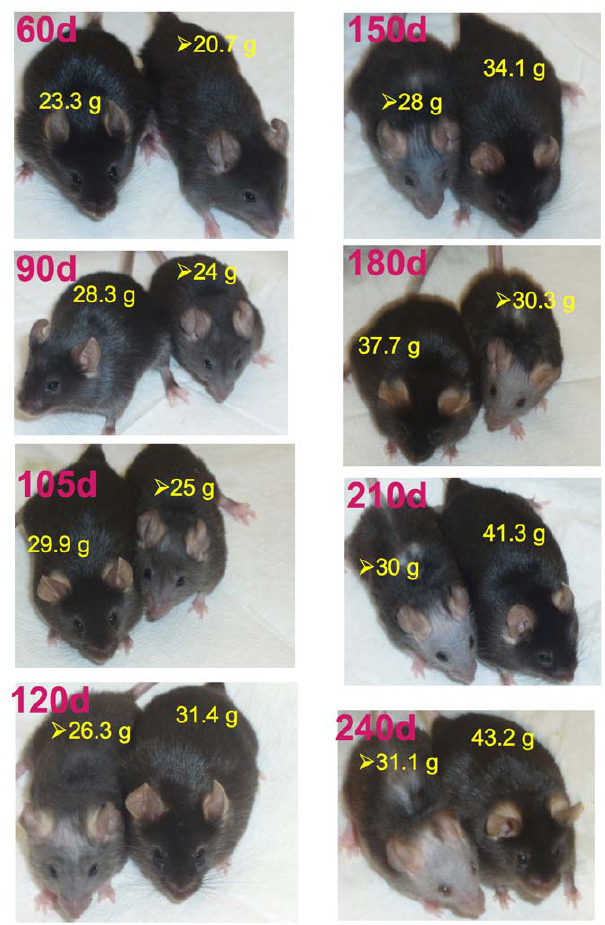
Figure 2. Photographic and weight comparison of a pair of sibling male TgI278TCbs 2 / 2 and TgI278TCbs + / 2 mice ranging from 60 to 240 days of age. Mice photographed from 60d-240d are the exact same pair. The TgI278T Cbs 2 / 2 animal in each pair is indicated by the arrow.